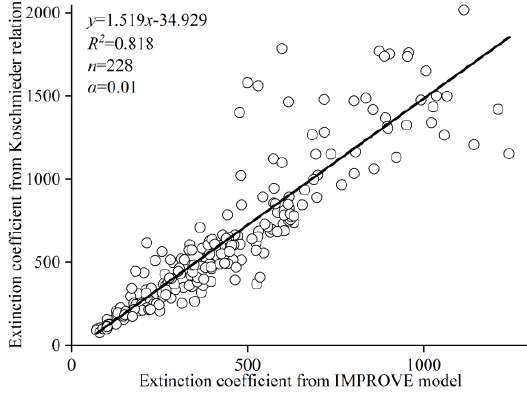
Figure 8. Linear fitting of the extinction coefficient from IMPROVE model and the extinction coefficient from Koschmieder relation.